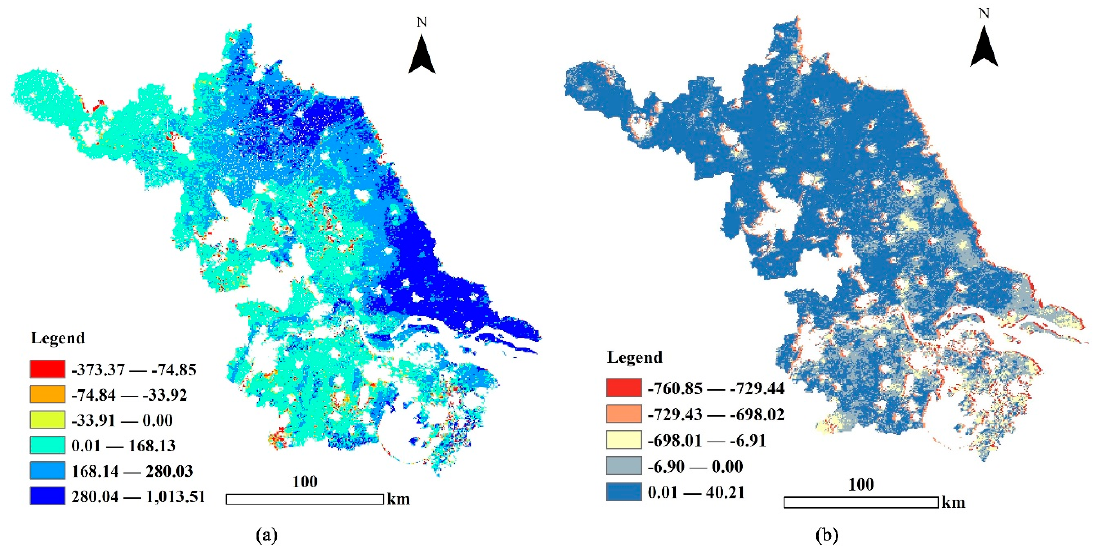
Figure 4. Spatial distribution of the annual mean value ( a ) and the changing trend of NEP (gC · m − 2 · yr − 1) ( b ).